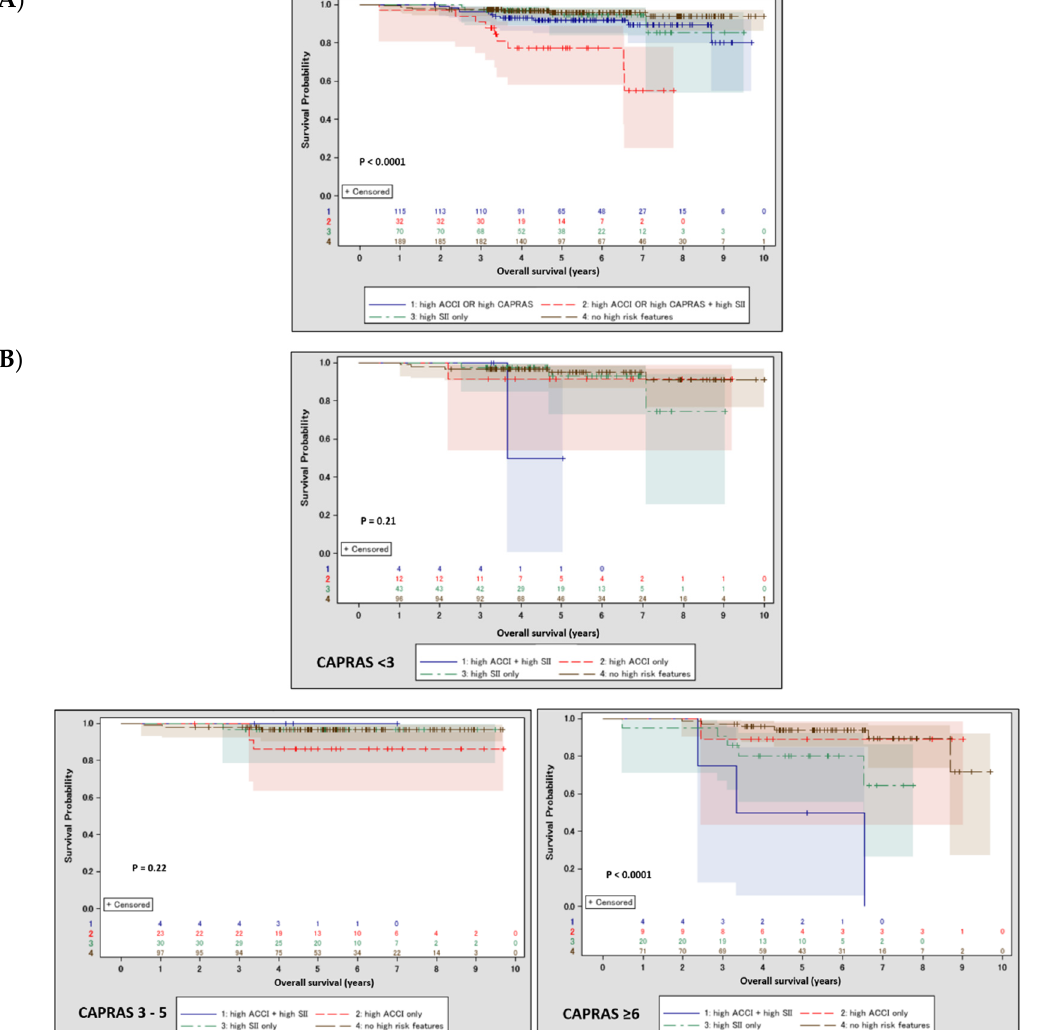
Figure 2. Kaplan-Meier curves with 95% confidence intervals depicting survival after radical prostatectomy depending on ACCI, CAPRA-S and SII. ( A ) Survival in patients stratified by the combination of either score with SII—entire cohort; ( B ) survival in patients stratified by the combination of ACCI with SII depending on the CAPRA-S risk group.